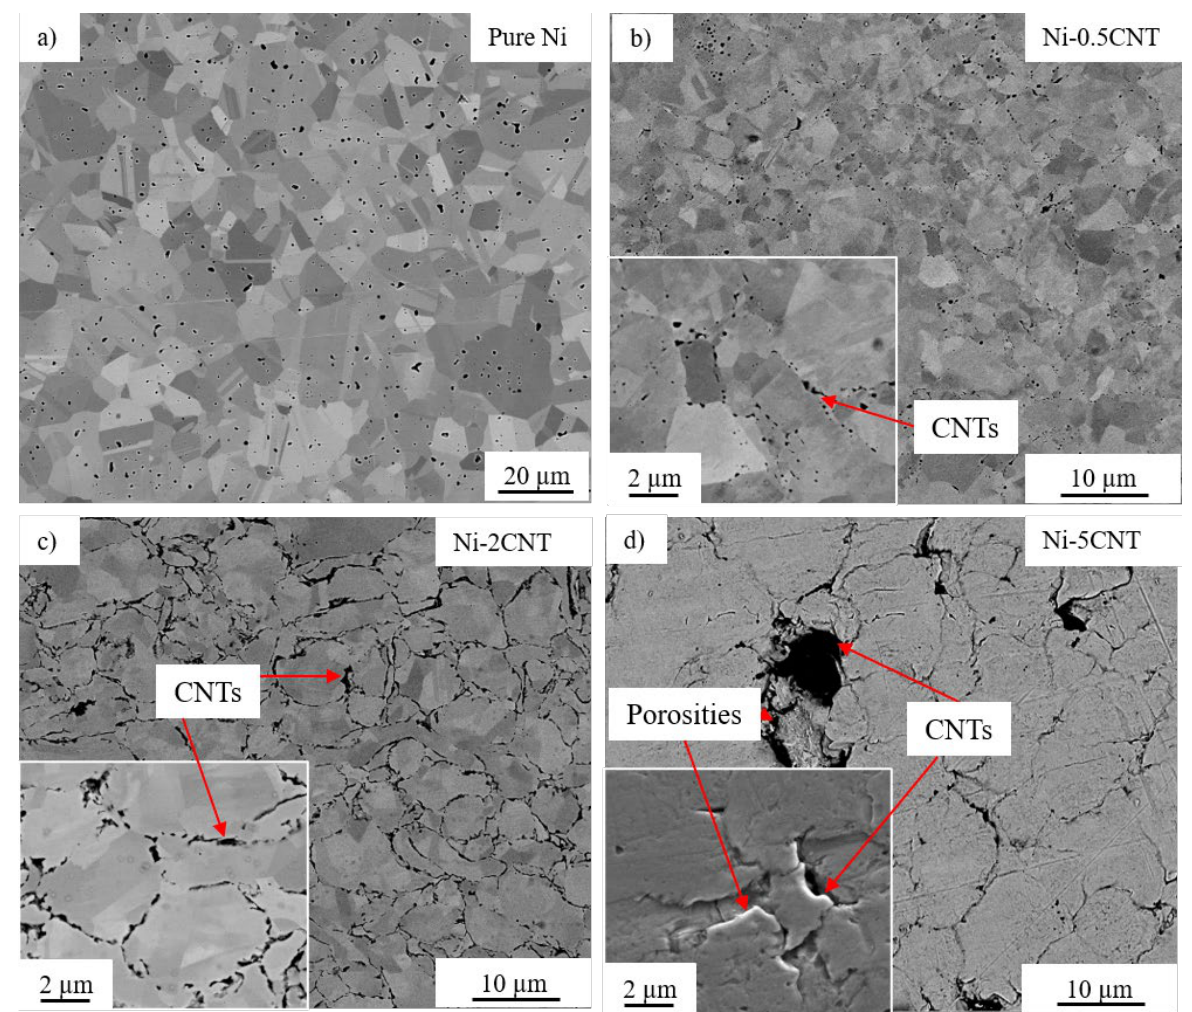
Figure 3. SEM micrographs of ( a ) pure Ni, ( b ) Ni-0.5CNT, ( c ) Ni-2CNT and ( d ) Ni-5CNT composite.